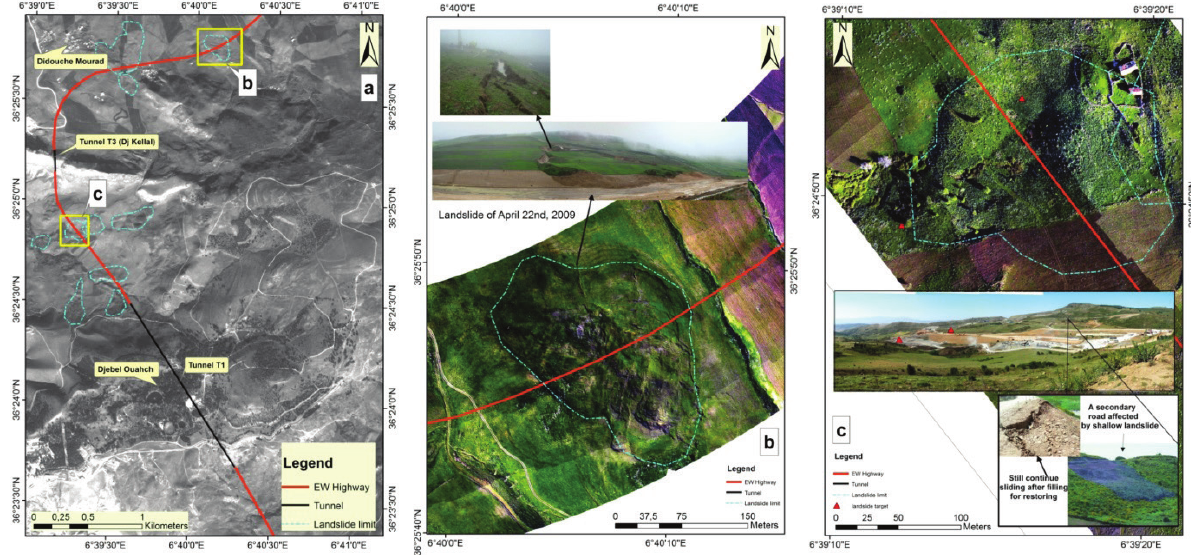
Figure 2: Optical remote sensing images and air photo used for the landslides determination in the study area: a- Panchromatic satellite image. b- A landslide occurred in highway’s segment before construction (air photo). c- A neighboring road affected by a rotational landslide.